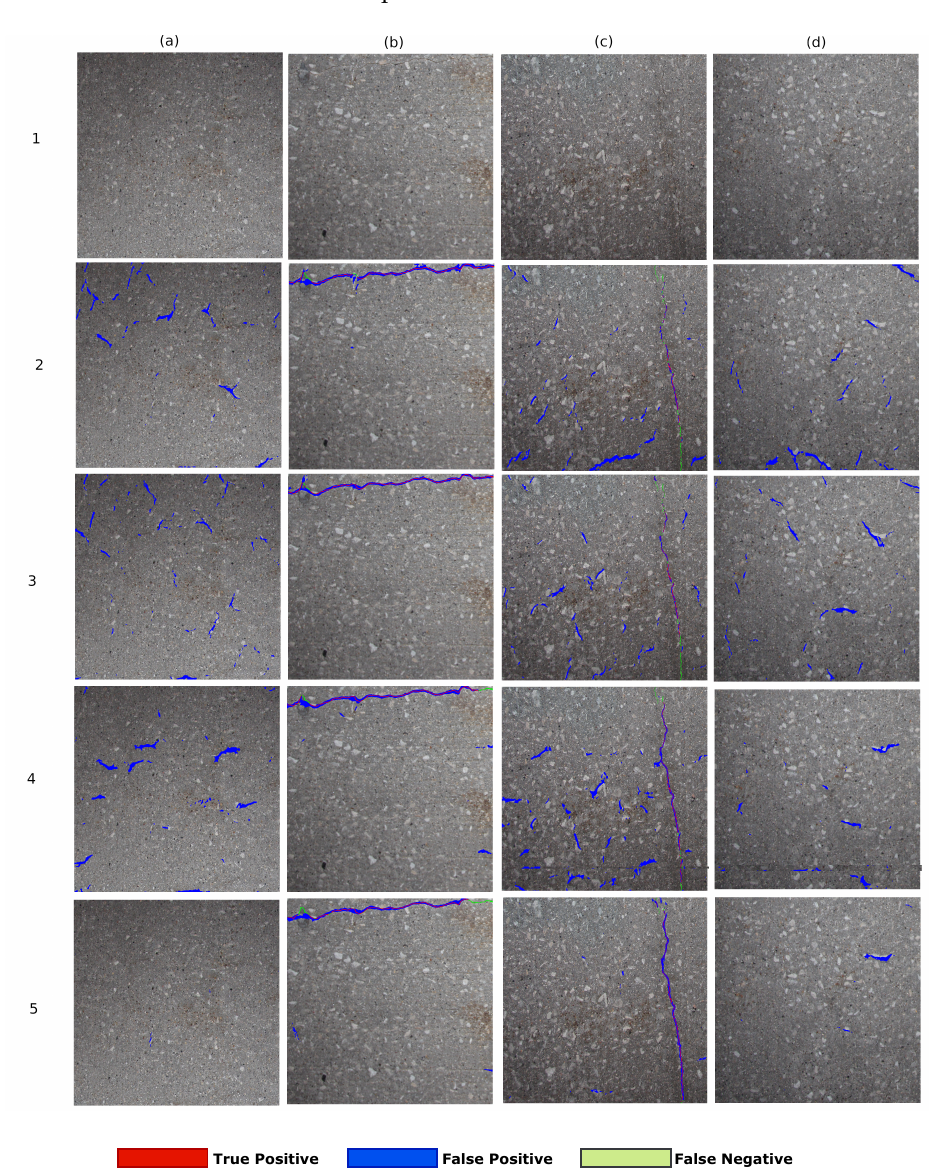
Figure 12. Comparison of different encoder-decoder-based architectures on four sample images. Columns are the tested images: ( a ) contains non-cracked concrete image, ( b ) contains clear horizontal crack on top, ( c ) contains clear vertical crack, ( d ) contains non-crack concrete image. Row 1—original image; Row 2—SegNet [42]; Row 3—SegNet-SO [4]; Row 4—InspectionNet; Row 5—ANet-FSM